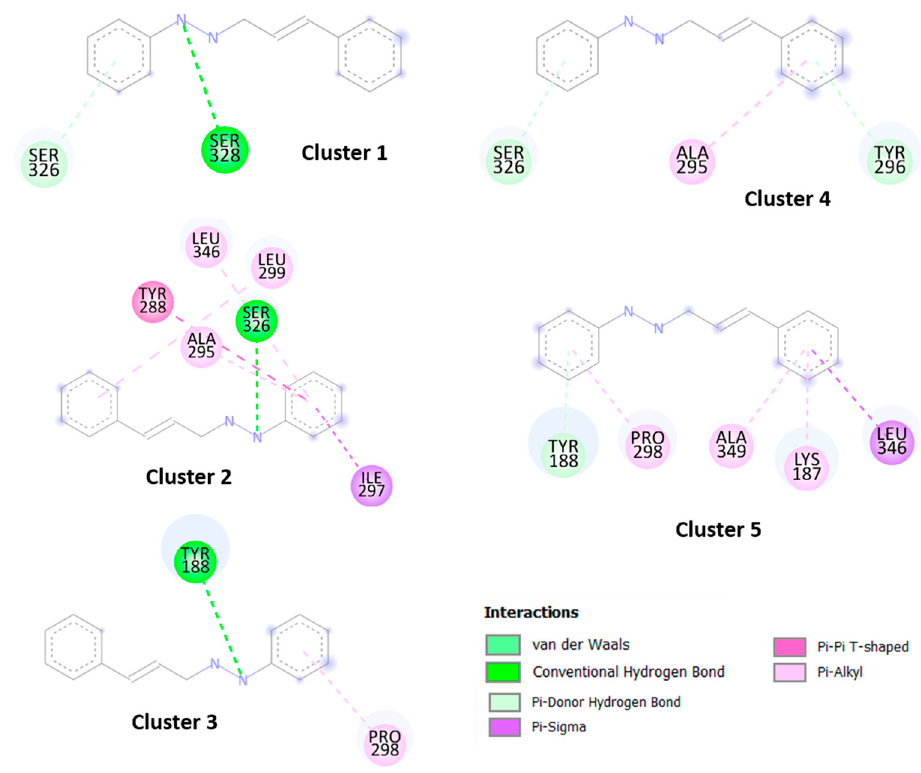
Figure 5. Here, 2D representation of interaction types of CPH with NO enzyme for the first five clusters.